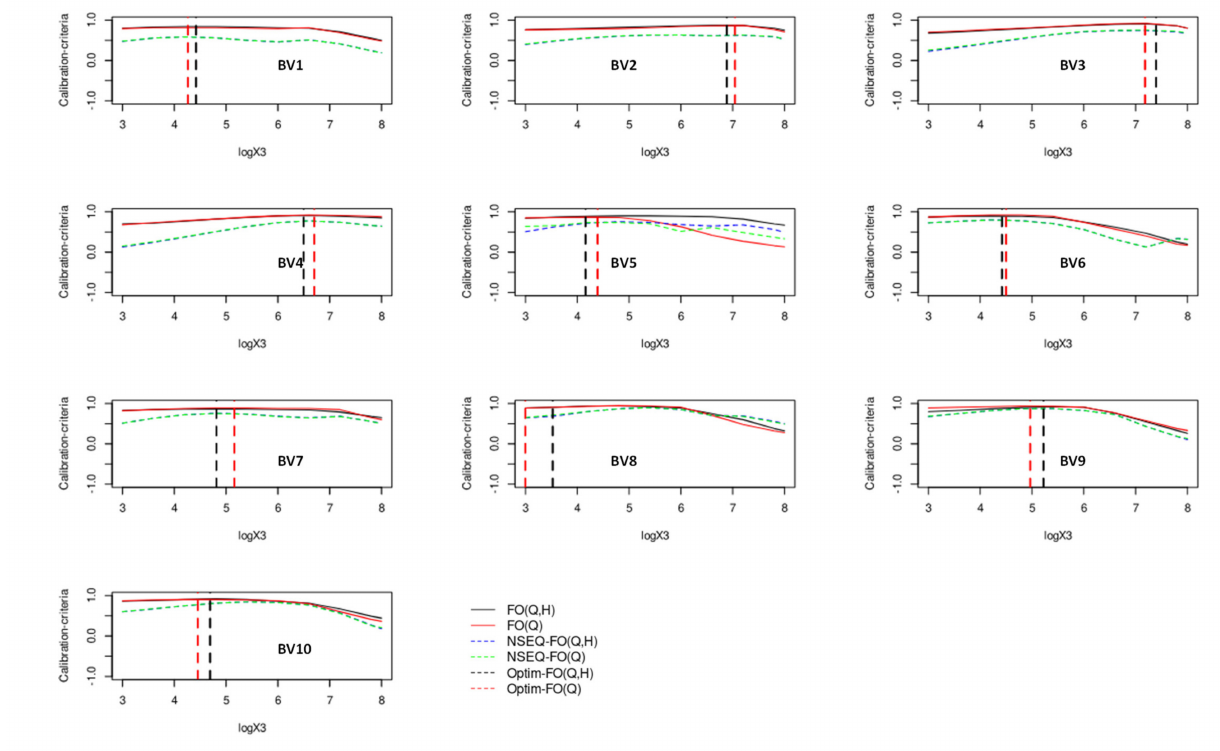
Figure 10. Summary of sensitivity analysis results to parameter C for the GRLoiEau2J model, with vertical lines (dotted) indicating optimal parameter values for each tested FO.